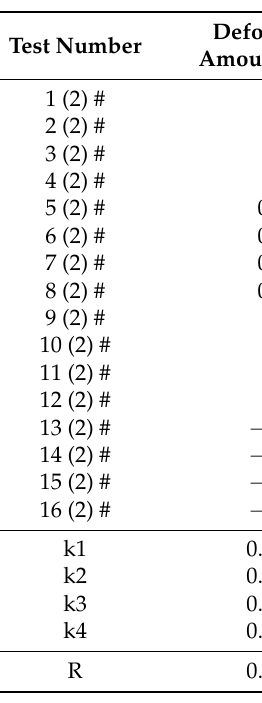
Table 4. Penetrations of the laser-welded Mo–Re sheets with a thickness of 2 mm, during a three-factor and four-level orthogonal